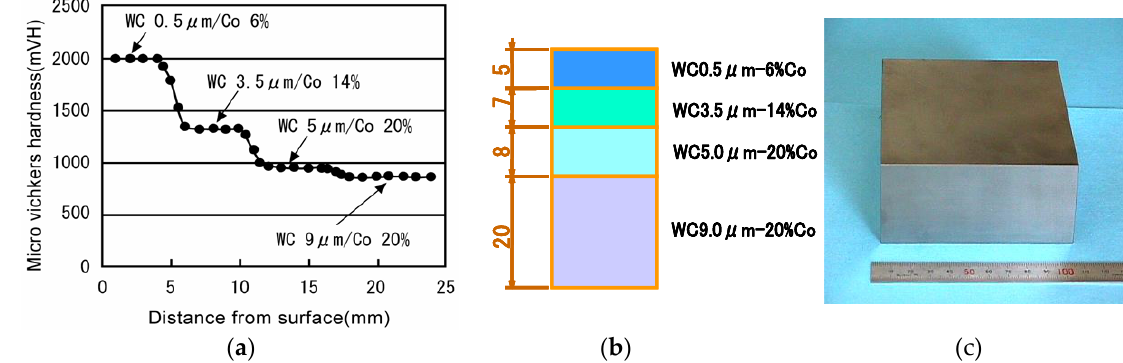
Figure 45. ( a ) Hardness gradient behavior of Large-size WC/Co FGMs fabricated by SPS (100 mm × 100 mm × 40 mm), ( b ) Profiles of 4 layered Co content graded WC/Co FGMs, and ( c ) Outside appearance of the SPSed WC/Co FGMs-